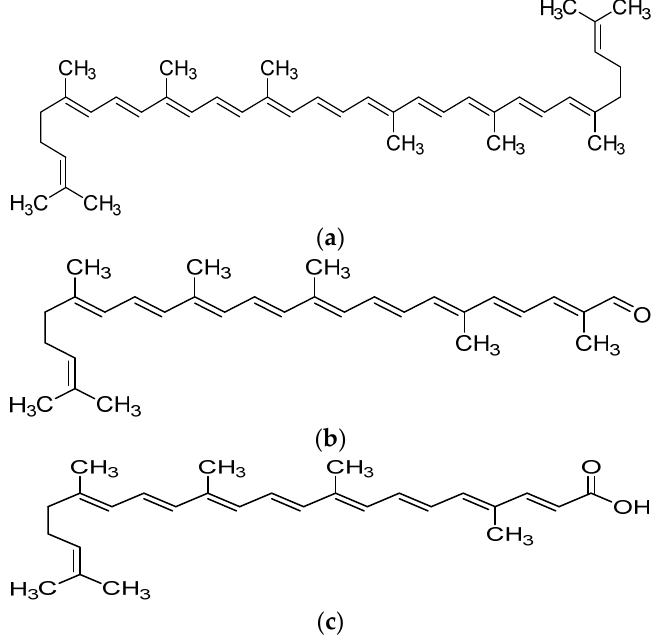
Figure 1. Chemical structure of lycopene and its metabolites with reported anti-cancer property. ( a ) Lycopene, ( b ) Apo-8 ′ -lycopenal, ( c ) Apo-10 ′ -lycopenoic acid.